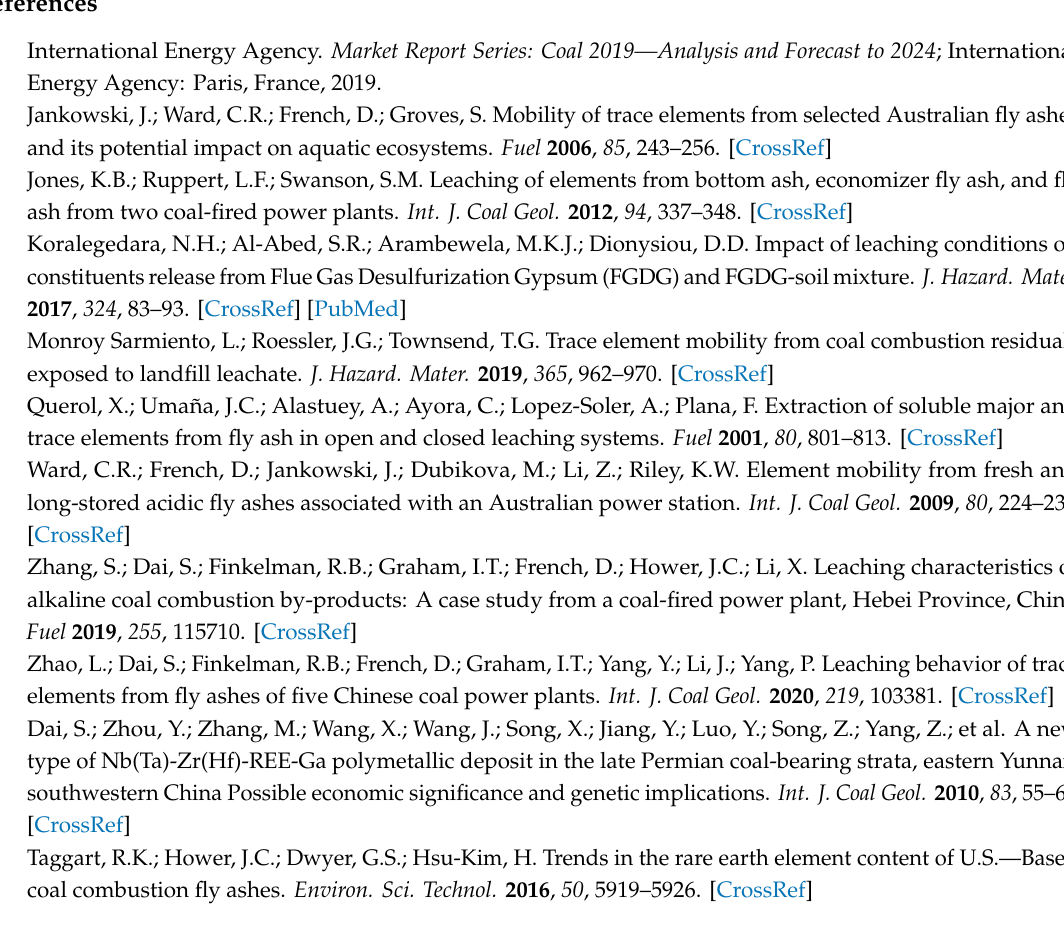
Table S1: Samples collected for the present study; Table S2: Proximate analysis (%) and total sulfur (%) of feed coals from the Xilaifeng and Damo power plants; Table S3: Mineralogical compositions of the low temperature ashes (LTAs) of feed coals (wt.%) for the Xilaifeng Power Plant by XRD and Siroquant analysis; Table S4: Mineralogical compositions of the low-temperature ashes (LTAs) of feed coals (wt.%) for the Damo Power Plant by XRD and Siroquant analysis; Table S5: Concentrations of trace ( µ g / g) and major (%) elements in the feed coals from the Xilaifeng Power Plant; Table S6: Concentrations of trace ( µ g / g) and major (%) elements in the feed coals from the Damo Power Plant; Table S7: Mineralogical compositions of the fly ashes from the Xilaifeng Power Plant (%); Table S8: Mineralogical compositions of the bottom ashes from the Xilaifeng Power Plant (%); Table S9: Mineralogical compositions of the fine fly ashes from the Damo Power Plant (%); Table S10: Mineralogical compositions of the coarse fly ashes from the Damo Power Plant (%); Table S11: Mineralogical compositions of the bottom ashes from the Damo Power Plant (%); Table S12: Concentrations of trace ( µ g / g) and major (%) elements in the fly ashes from the Xilaifeng Power Plant; Table S13: Concentrations of trace ( µ g / g) and major (%) elements in the bottom ashes from the Xilaifeng Power Plant; Table S14: Concentrations of trace ( µ g / g) and major (%) elements in the fine fly ashes from the Damo Power Plant; Table S15: Concentrations of trace ( µ g / g) and major (%) elements in the coarse fly ashes from the Damo Power Plant; Table S16: Concentrations of trace ( µ g / g) and major (%) elements in the bottom ashes from the Damo Power